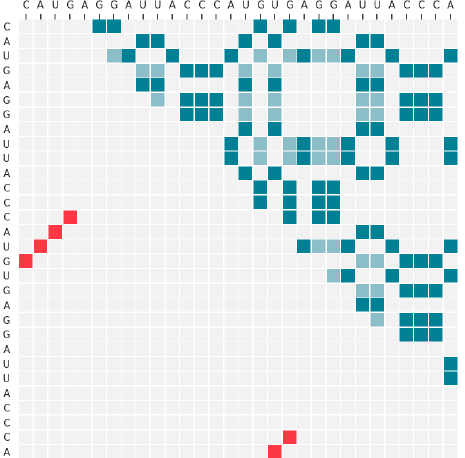
Figure 9. The secondary structure of RNA PDB_00972 and its initial action space. The native secondary structure is located in the lower right corner, indicated in red; the initial action space is located in the upper left half corner, indicated in blue.